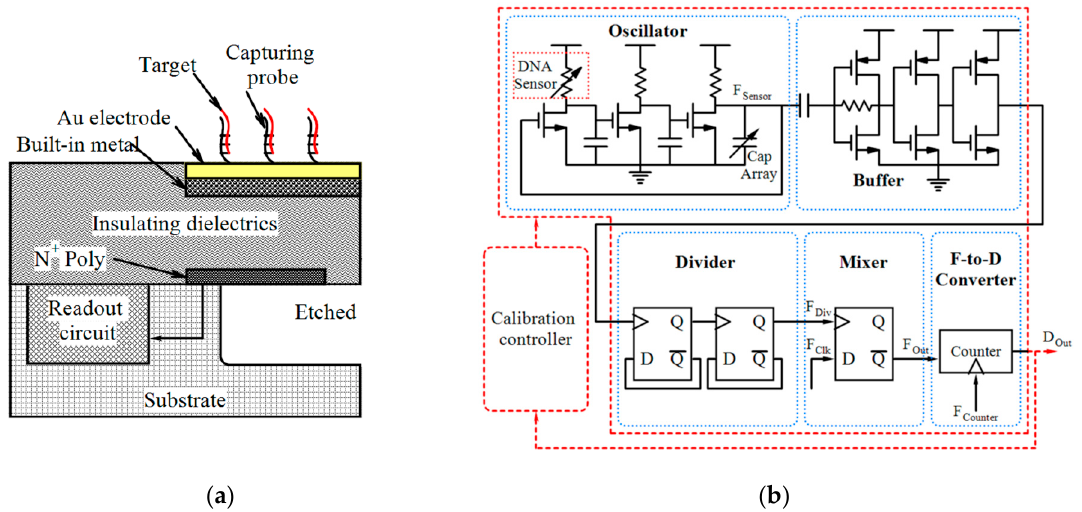
Figure 14. ( a ) Mechanical-based detection with cantilever; ( b ) Block diagram of a cantilever-based system on chip. system on